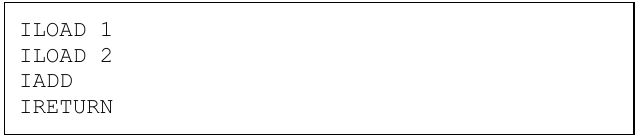
Fig. 3. JVM bytecode using mathematical operations and local variables.